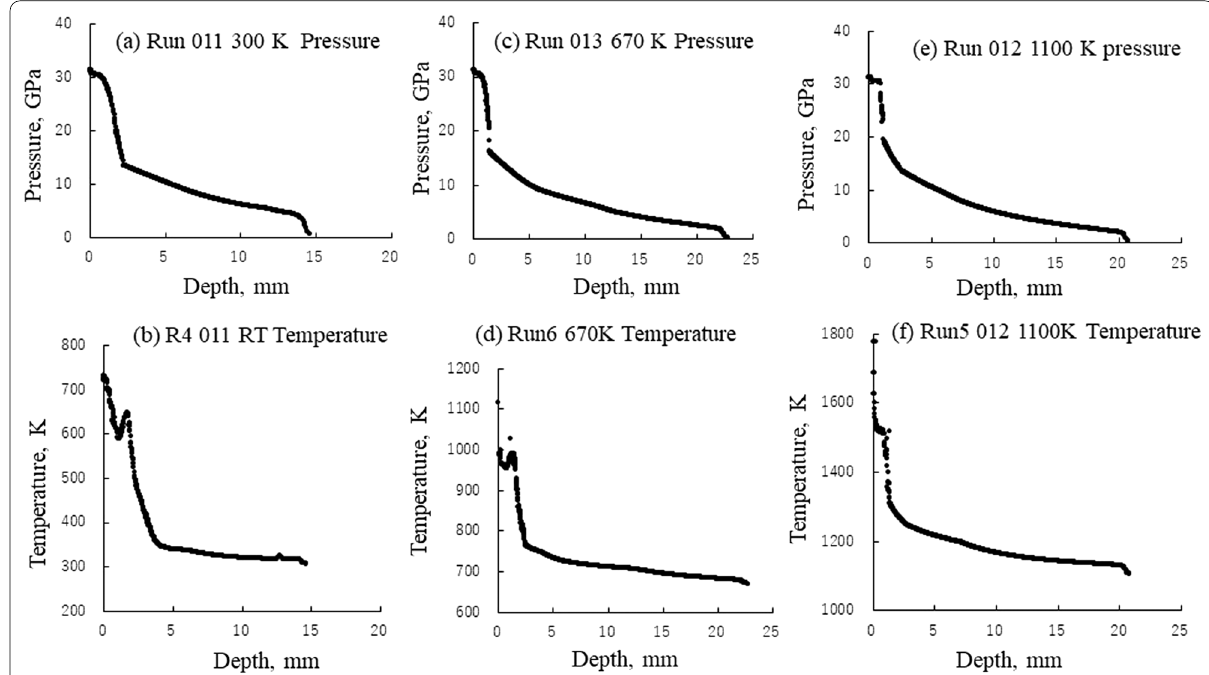
Fig. 11 The results of the iSALE-2D simulation on distributions of the peak pressure (GPa) and temperature (K) along the center axis of the target. The distribution of peak pressure ( a ) and temperature ( b ) in the room temperature impact (corresponding to Run 011), the peak pressure ( c ) and temperature ( d ) in the impact at 670 K (corresponding to Run 013), and the peak pressure ( e ) and temperature ( f ) in the 1100 K impact (corresponding to Run 012). The distance from the crater is shown as the depth in mm